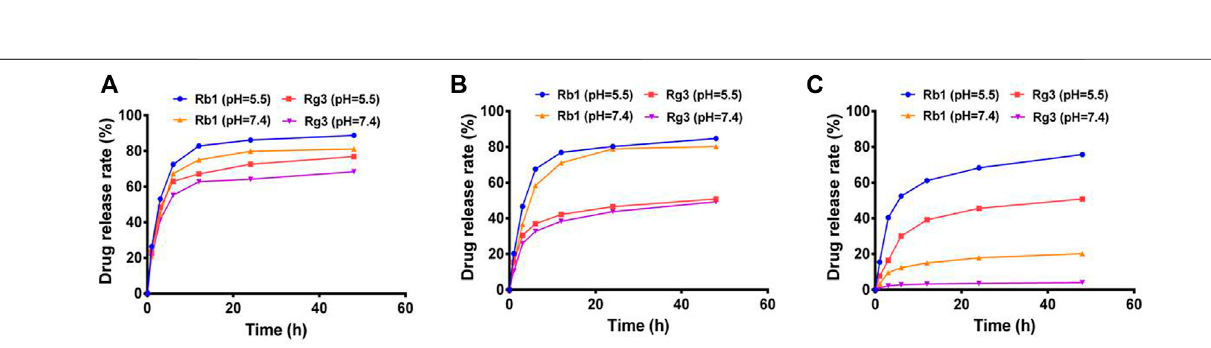
Frontiers in Bioengineering and Biotechnology |